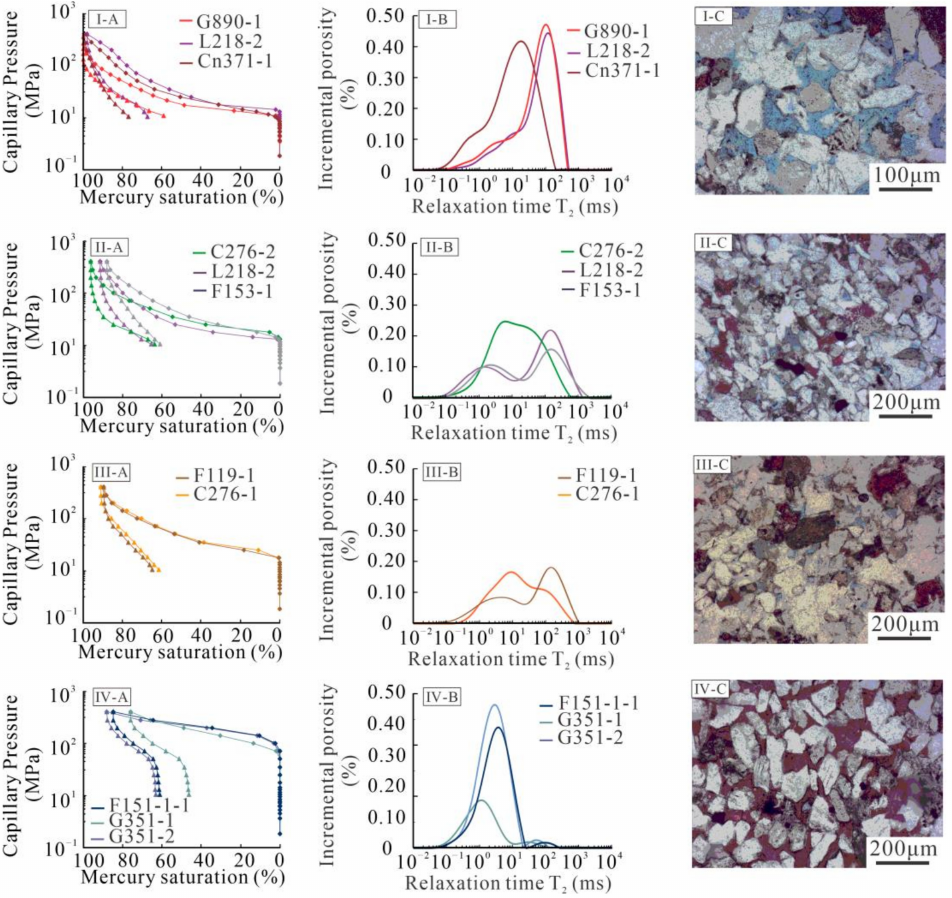
Figure 16. ( I-A – IV-C ) Classification and evaluation of various types of pore structures in the E s4 sandstone reservoirs, showing the microscopic pore types and pore throat characteristics for different types of pore structures.